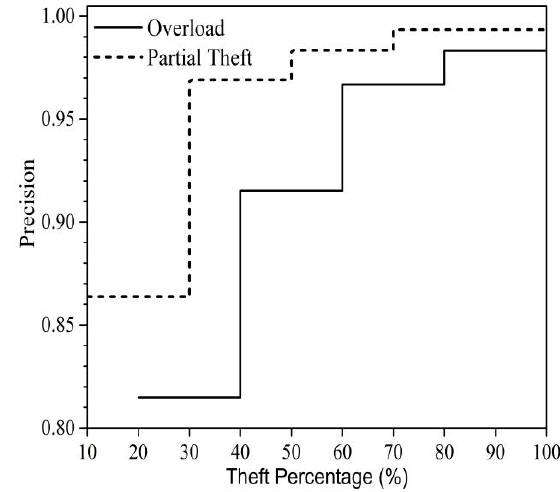
Figure 9. F1 metric for partial power theft and overload scenarios. Energies 2020 , 13 , x FOR PEER REVIEW